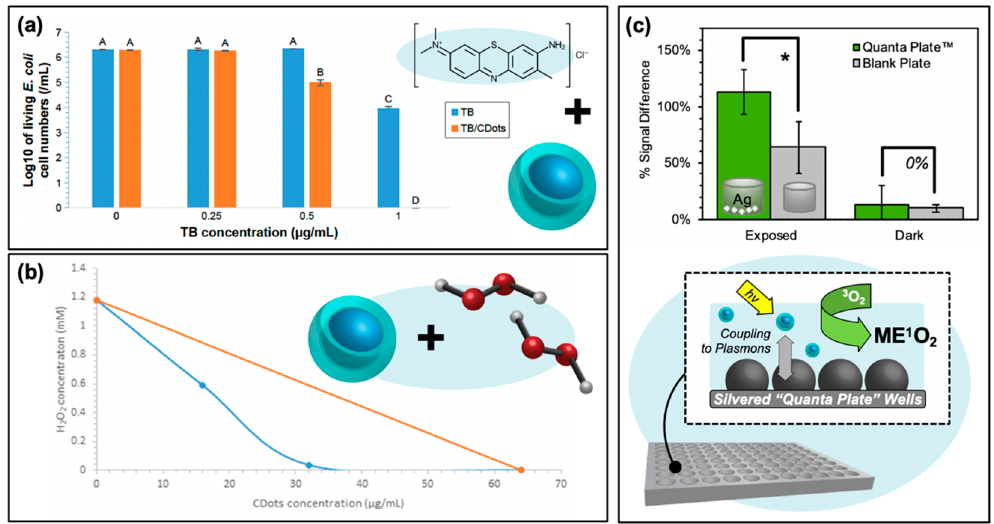
Figure 9. Carbon nanodots in hybrid systems for optimizing reactive oxygen species